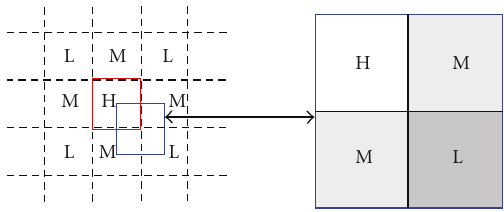
Figure 6: Sliding Window of Method